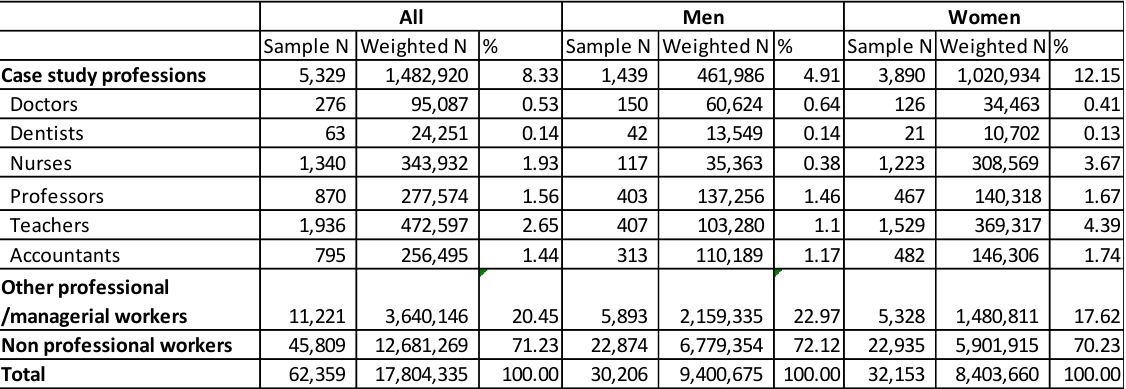
Table 1. Occupational distribution of case study professions, aged 15+, Canada 2013-14.